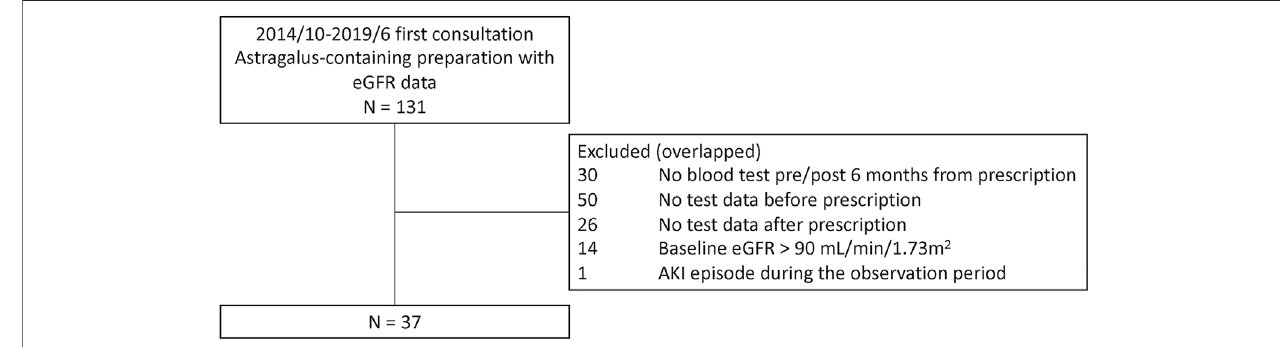
FIGURE 1 | Patient exclusion fl owchart. A total of 131 potential study participants were identi fi ed at the Keio University Hospital Kampo Clinic between 1 October 2014, and 31 June 2019, of which 37 patients were included in the fi nal